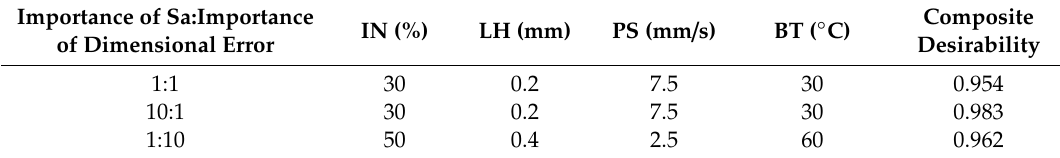
Table 3. The experiments and results for roughness and dimensional